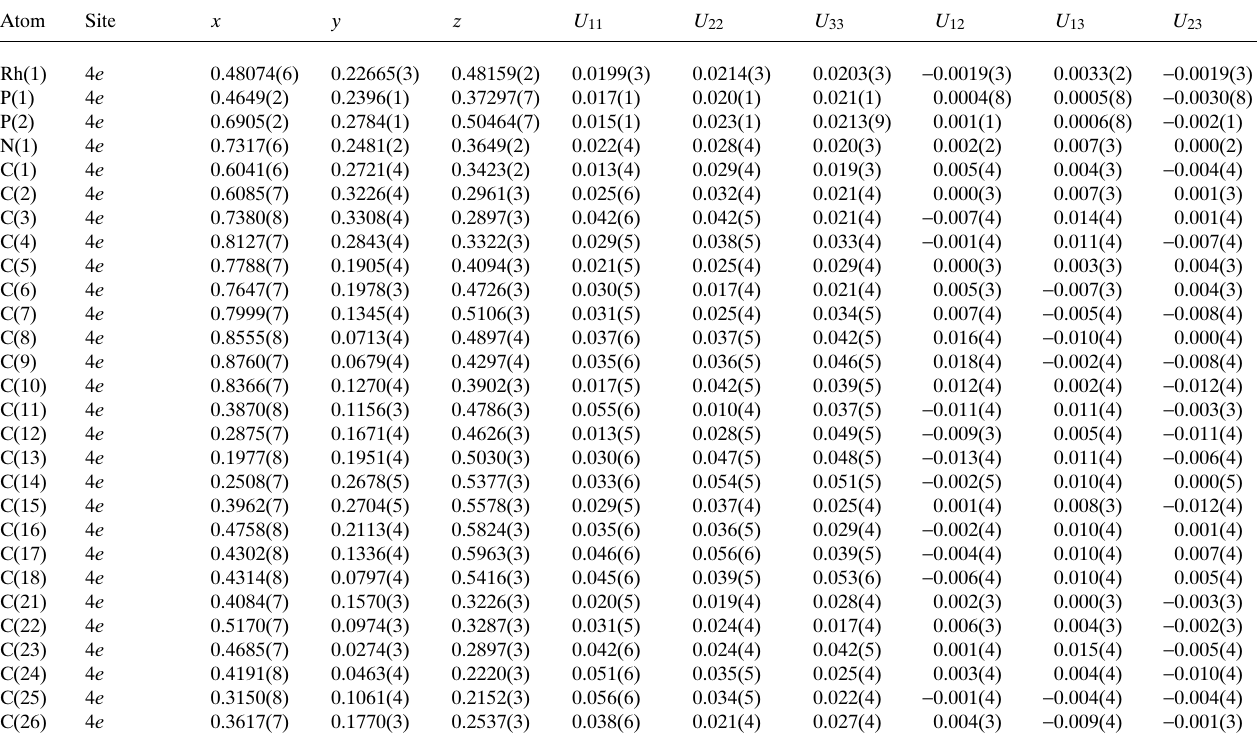
Table 6. Atomic coordinates and displacement parameters (in Å 2 )